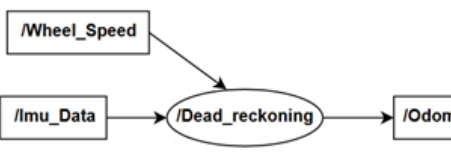
Figure 8. The ROS odometry topics structure.